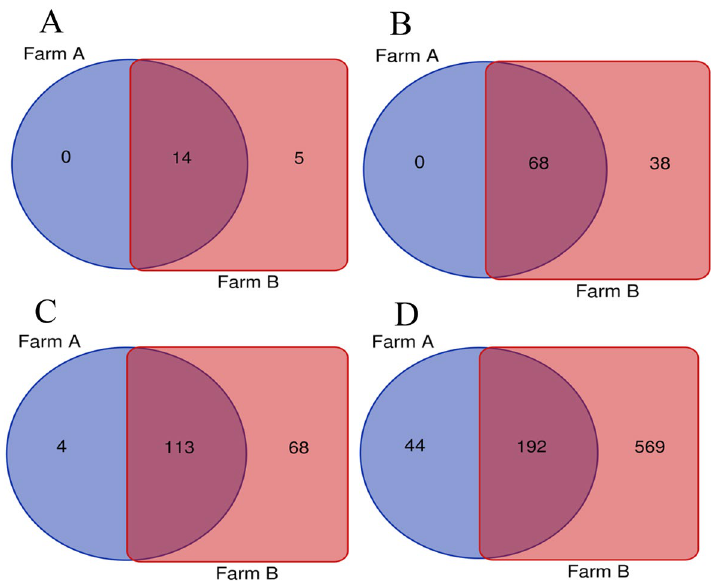
Figure 3. Venn diagrams showing shared taxa among farm A and B the at the: ( A) phyla level; ( B ) order level; ( C ) family level; ( D ) genus